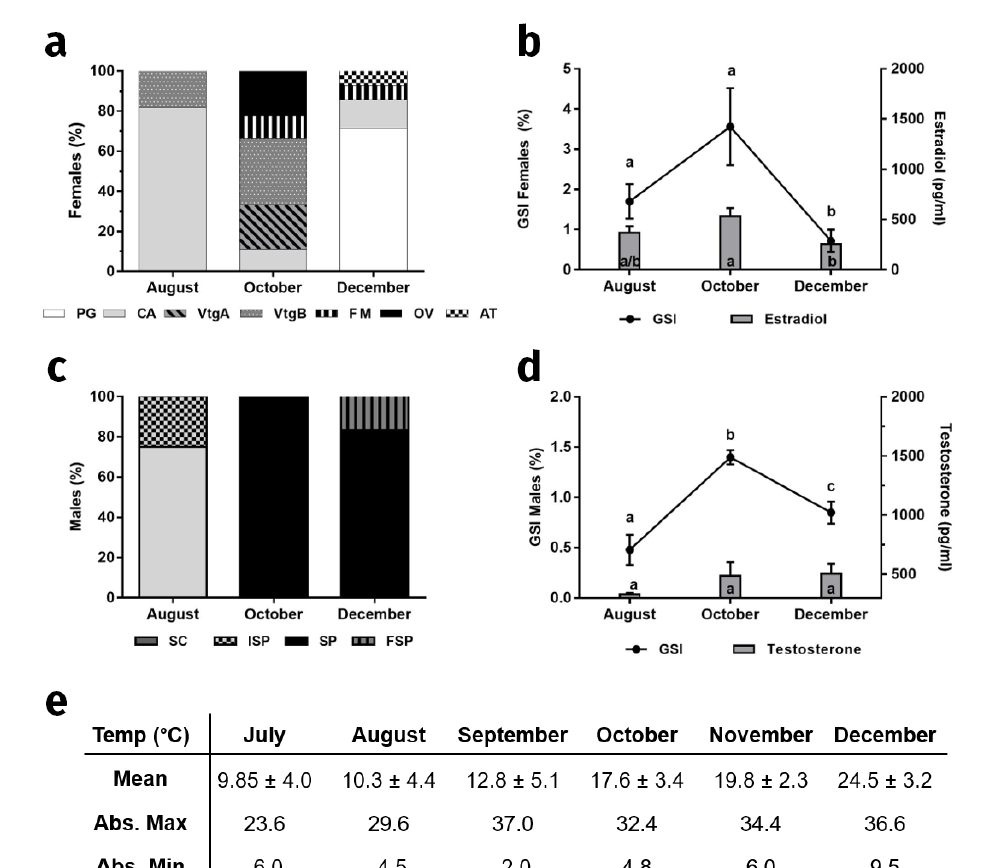
Figure 2. Pejerrey ( O. bonariensis ) sampling in Gómez lake (2013). a) Percentage of females at different gonadal stages. CA: cortical alveoli stage; VtgA: initial vitellogenesis stage; VtgB: advanced vitellogenesis stage; FM: final maturation stage; OV: ovulated females; AT: atretic stage. b) Female gonadosomatic indexes (GSI: dots) and E2 plasma levels (bars). Values are mean ± SEM. Different letters represent significant differences between sampling dates (Tukey’s multiple comparison test. p < 0.05). c) Percentage of males at different gonadal stages. ISP: Initial spermiogenic; SP: spermiogenic; FSP: final spermiogenic; A: arrested. d) Male gonadosomatic indexes (GSI: dots) and T plasma levels (bars). Values are mean ± SEM. Different letters represent significant differences between sampling dates (Tukey’s multiple comparison test. p < 0.05). e) Air temperature (°C) during the spawning season. Mean: Monthly mean temperature; Abs. Min.: Absolute Minimum; Abs. Max.: Absolute